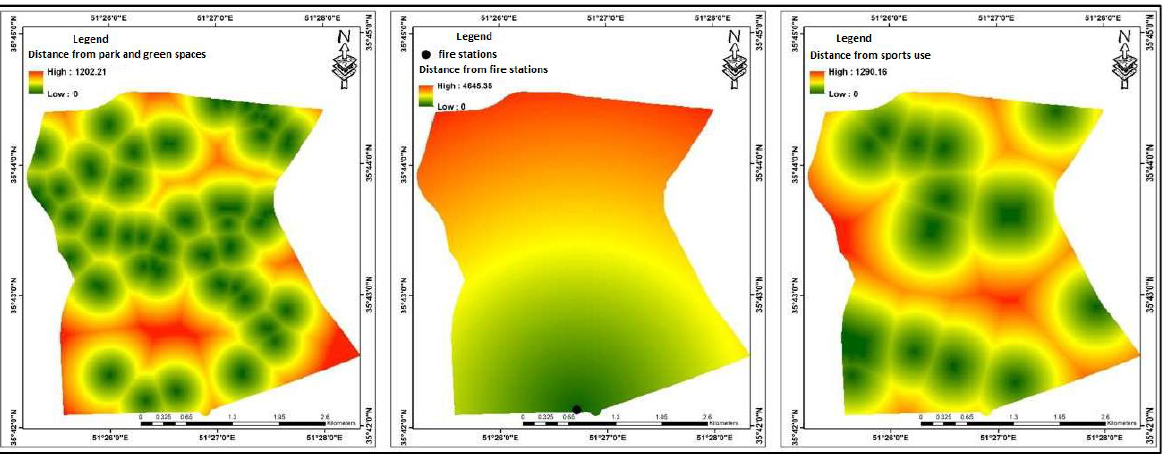
Figure 3. Distance from compatible uses.